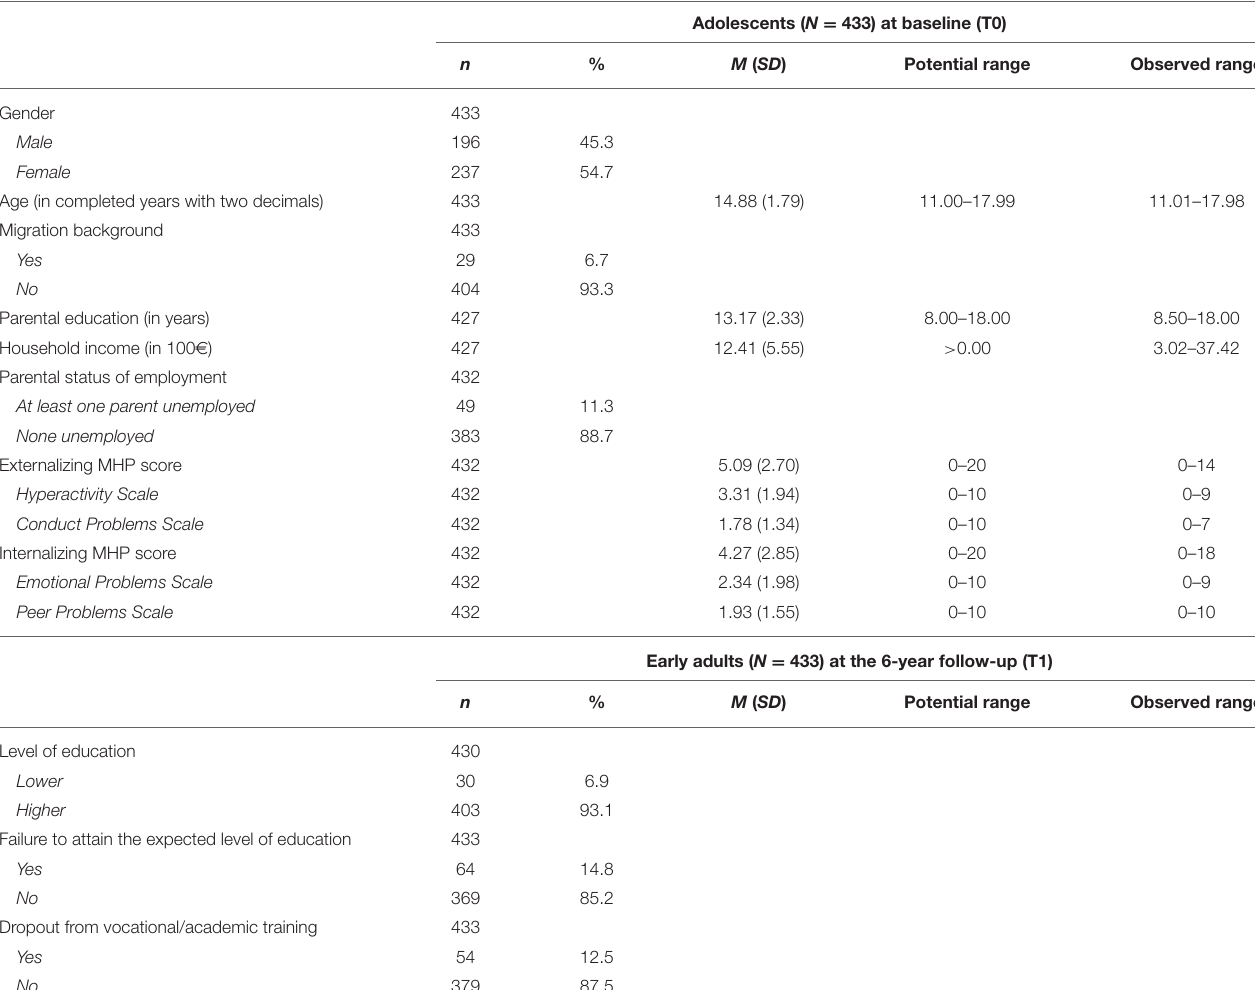
TABLE 1 | Sample characteristics at baseline (T0) and outcome measures at 6-year follow-up